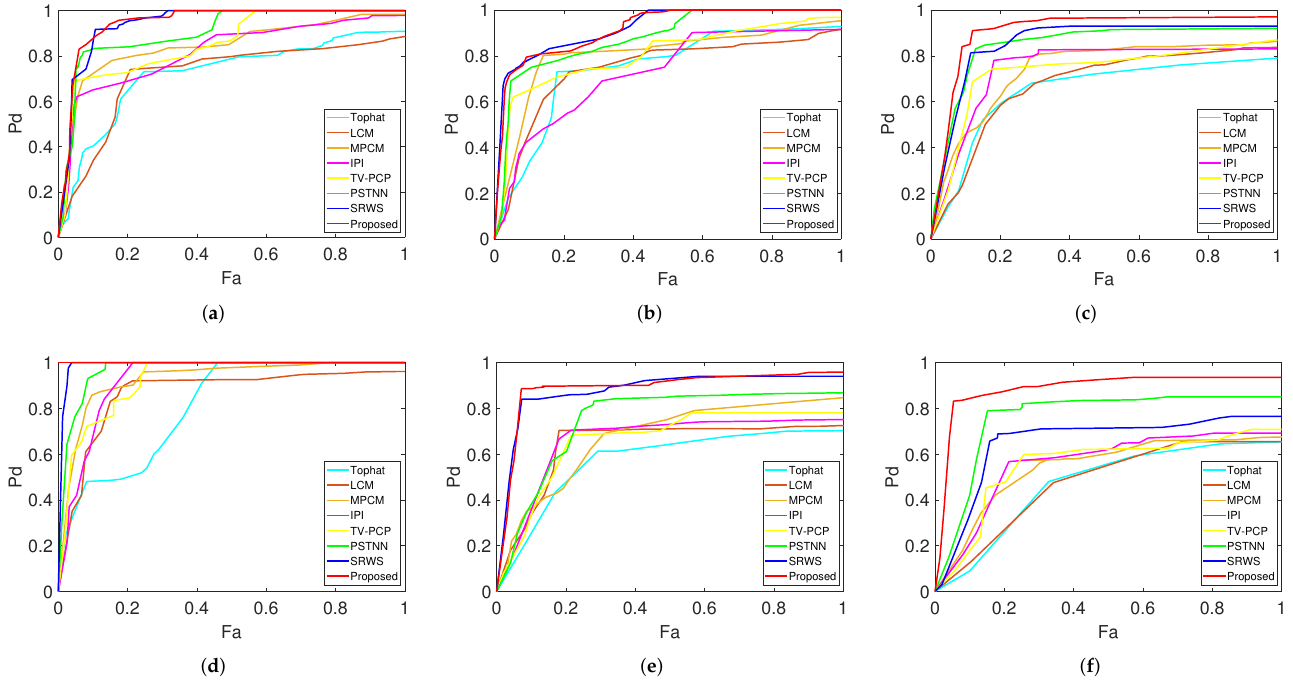
Figure 12. ROC curve of eight methods. ( a ) Seq1. ( b ) Seq2. ( c ) Seq3. ( d ) Seq4. ( e ) Seq5. ( f )